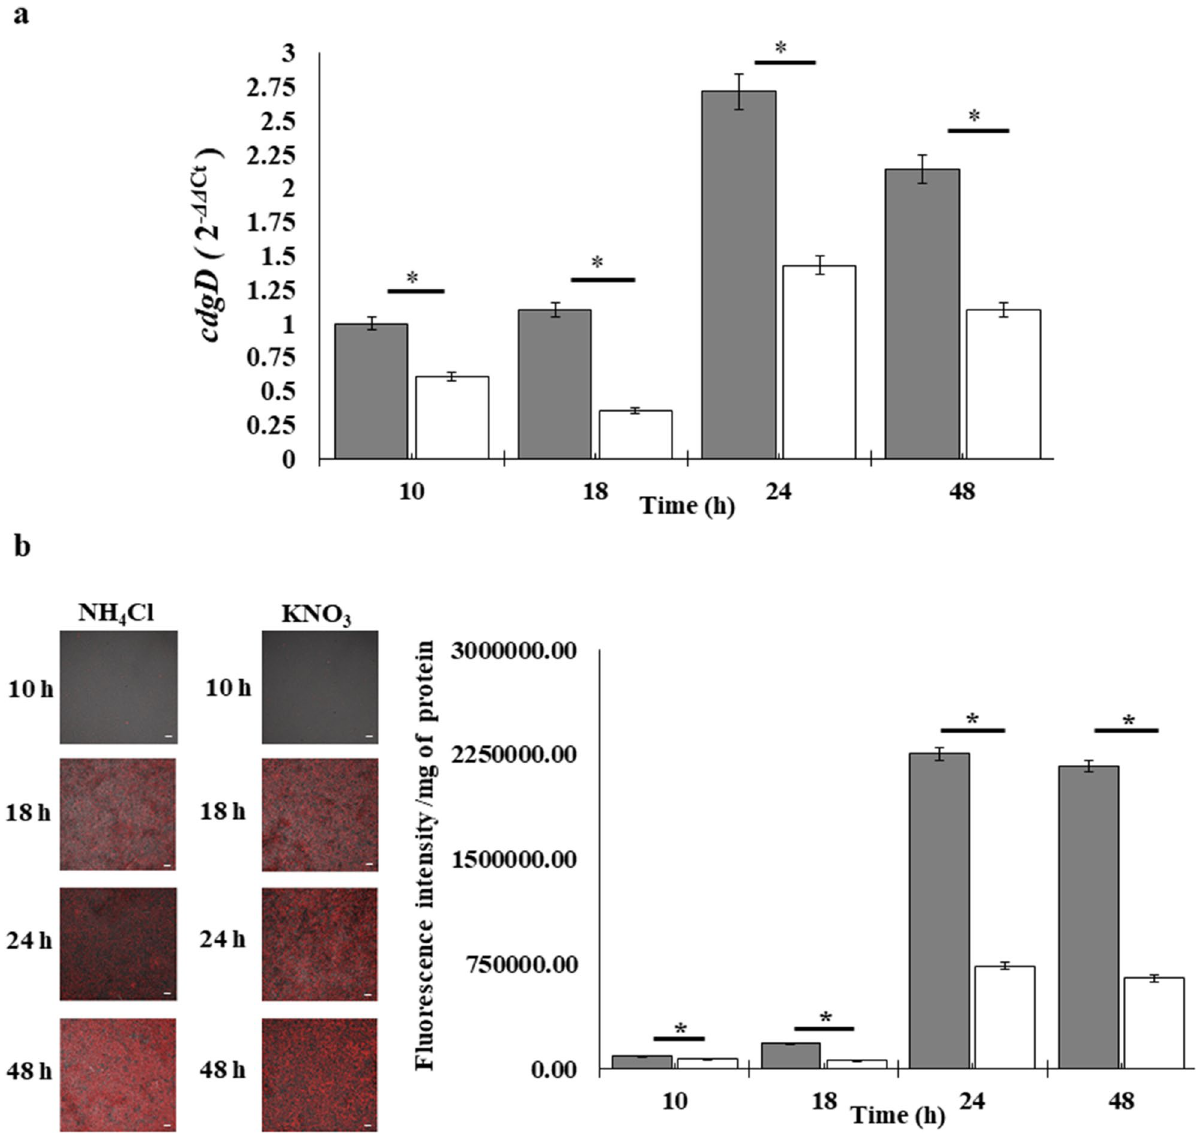
Figure 5. Expression analysis of the cdgD gene from planktonic and static cultures of the A. brasilense Sp245 strain. ( a ) Determination of cdgD gene transcript levels by RT-qPCR. The transcript level data were normalized to those of the reference gene glyA and determined relative to the control sample using Applied Biosystems StepOne software. ( b ) Fluorescence micrographs of the A. brasilense FPDm1 strain under different culture conditions. Left, bacteria grown in NFB* + KNO 3 media; right, bacteria grown in NFB* + NH 4 Cl media. The fluorescence intensity is normalized to total protein values from the A. brasilense FPDm1 strain, as analysed using ImageJ 35 . The presented data are the results of three independent experiments with two biological replicates, and the asterisks indicate significant differences from the wild type ( P < 0.05) according to Student’s T test by SigmaPlot (Systat Software, San Jose, CA). The bar corresponds to 10 µm. NFB* + KNO 3 , NFB* + NH 4 Expression of the cdgD gene under abiotic and biotic conditions. Next, we monitored cdgD expression by RT- qPCR in exponential- and stationary-phase cultures grown in NFB* supplemented with KNO 3 or NH 4 Cl under shaking (10 and 18 h) and static conditions (24 and 48 h) and by using the tagged chromosomal A. brasilense FPDm1 strain and A. brasilense T7mCh, carrying the mCherry gene devoid of the promoter as a negative control. Both strains showed similar growth to the wild-type strain, as determined by the 10 9 CFU/mL value obtained in the exponential phase of growth (18 h), (Fig. 5). In both media, the expression of cdgD was initiated at 10 h and continued until 48 h, in cultures growing in planktonic and static conditions. These observations indicate that the expression of the gene is initiated at the beginning of bacterial growth and continues until the later stages of growth. The amount of fluorescence produced was higher in cells growing in NFB* + KNO 3 medium compara- tive to NFB* + NH 4 Cl, (Fig. 5b), indicating that the addition of KNO 3 to the medium increased transcript levels relative to those obtained in presence of NH 4 Cl, where expression was further increased when the structure of